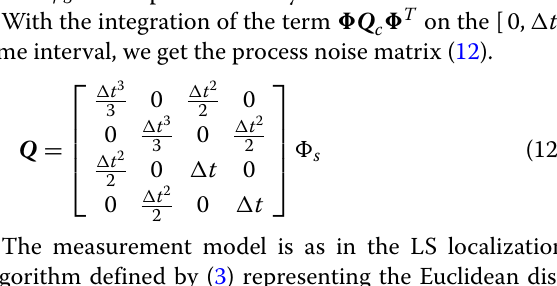
algorithm defined by (3) representing the Euclidean dis- tance between the tracked object and the anchor